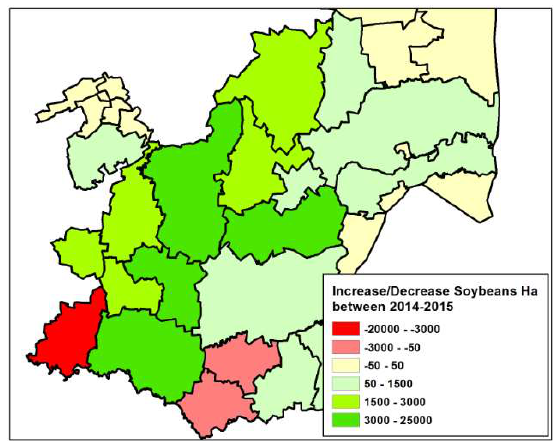
Figure 17. Calculated increase or decrease in area (Ha) of maize cultivated in 2015 and 2016 in Mpumalanga